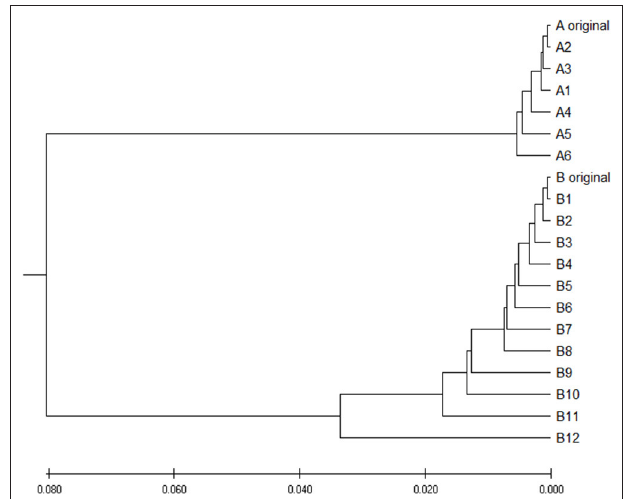
FIGURE 8 | The phylogenetic UPGMA tree using Jukes-Cantor pairwise alignment method on simulated